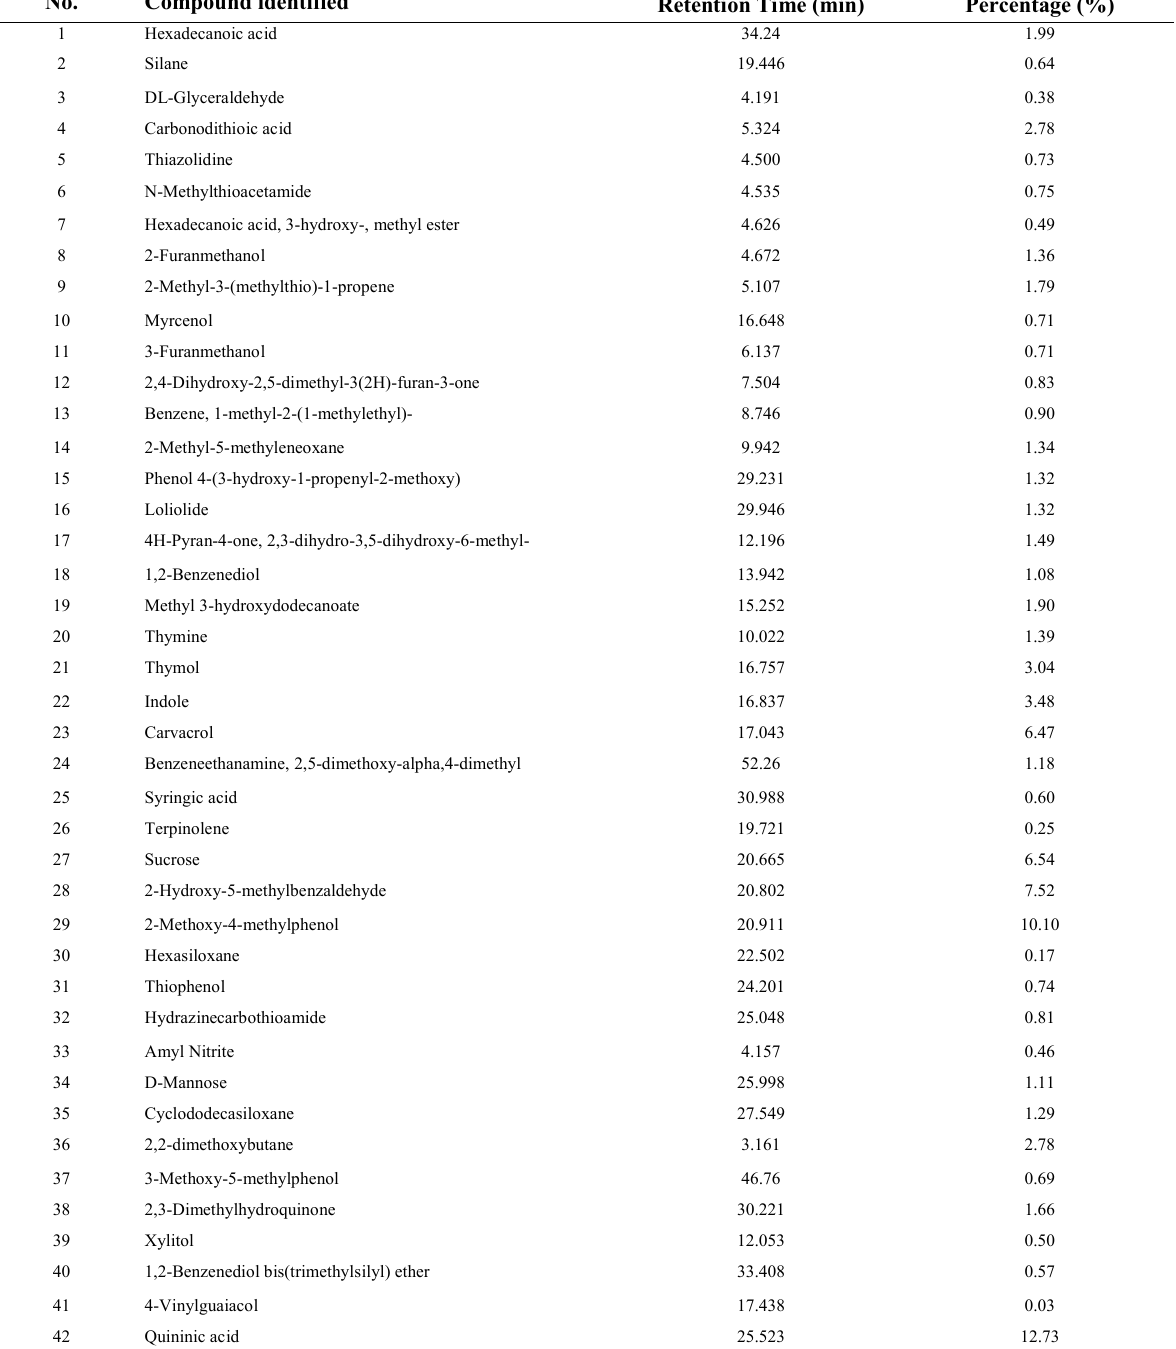
Table 5. Chemical constituents of Thymus vulgaris extract, based on GC-MS analysis (Heidari et al., 2018).